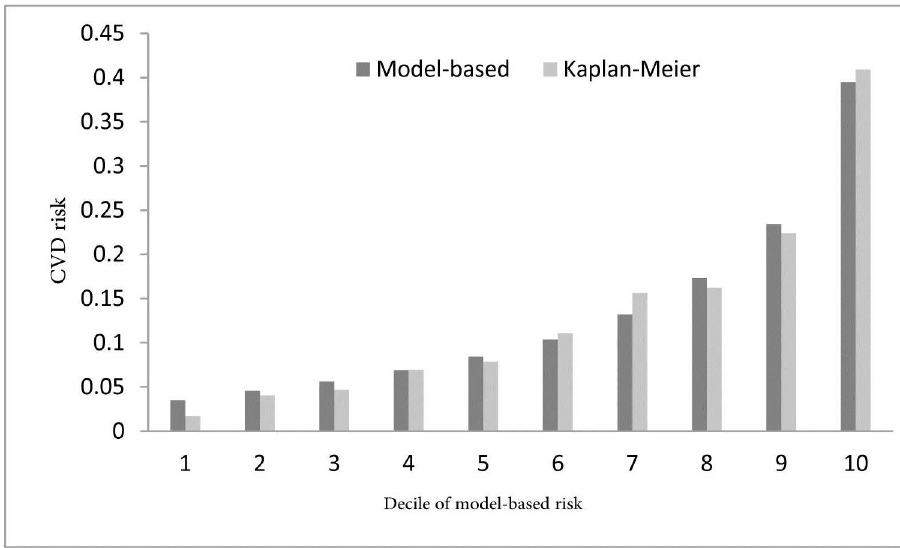
Fig 2. Comparison between observed and estimated 10-yearrisk of CVD using the PARS risk function.